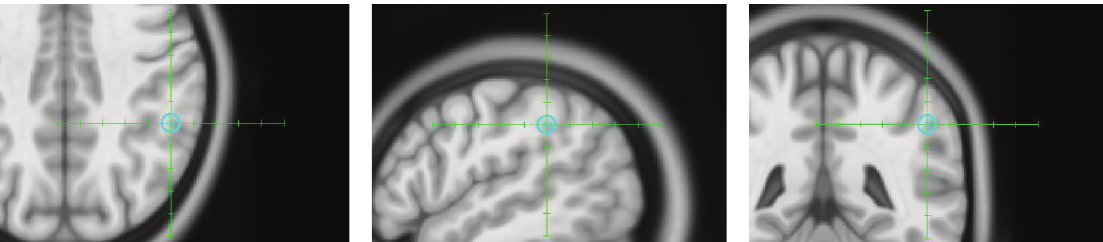
Figure 2: Target stimulation site in the right posterior parietal